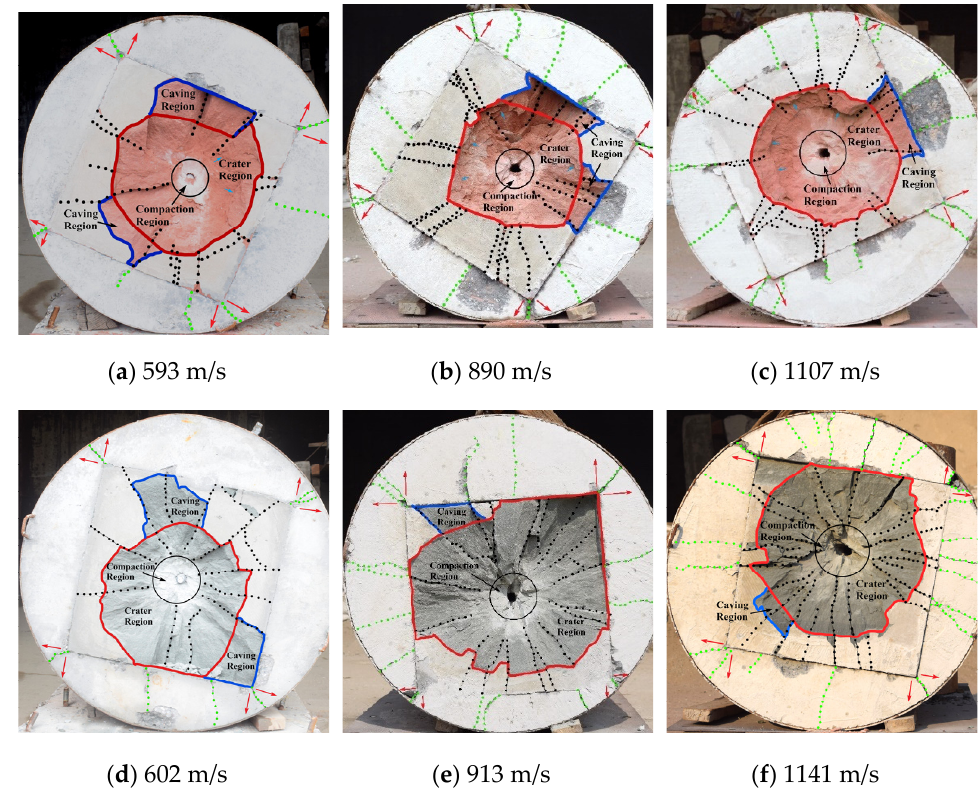
Figure 5. Red sandstone and limestone targets after tests: ( a – c ) are red sandstone; ( d – f ) are lime- stone.